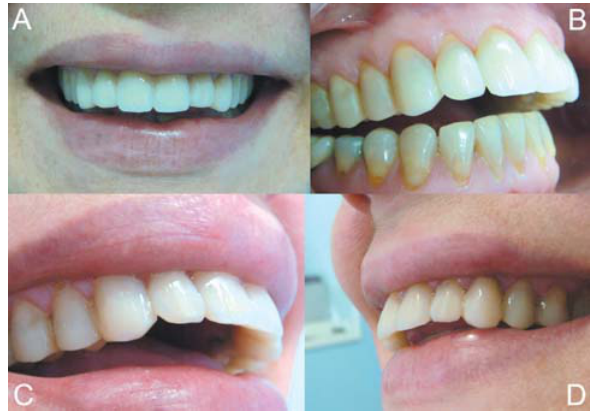
FIGURE 7- Esthetic results of oral rehabilitation follow-up after 2 years. A: Patient smile after new polishing; B: correct contour of posterior and anterior teeth; C,D: closer view of restored